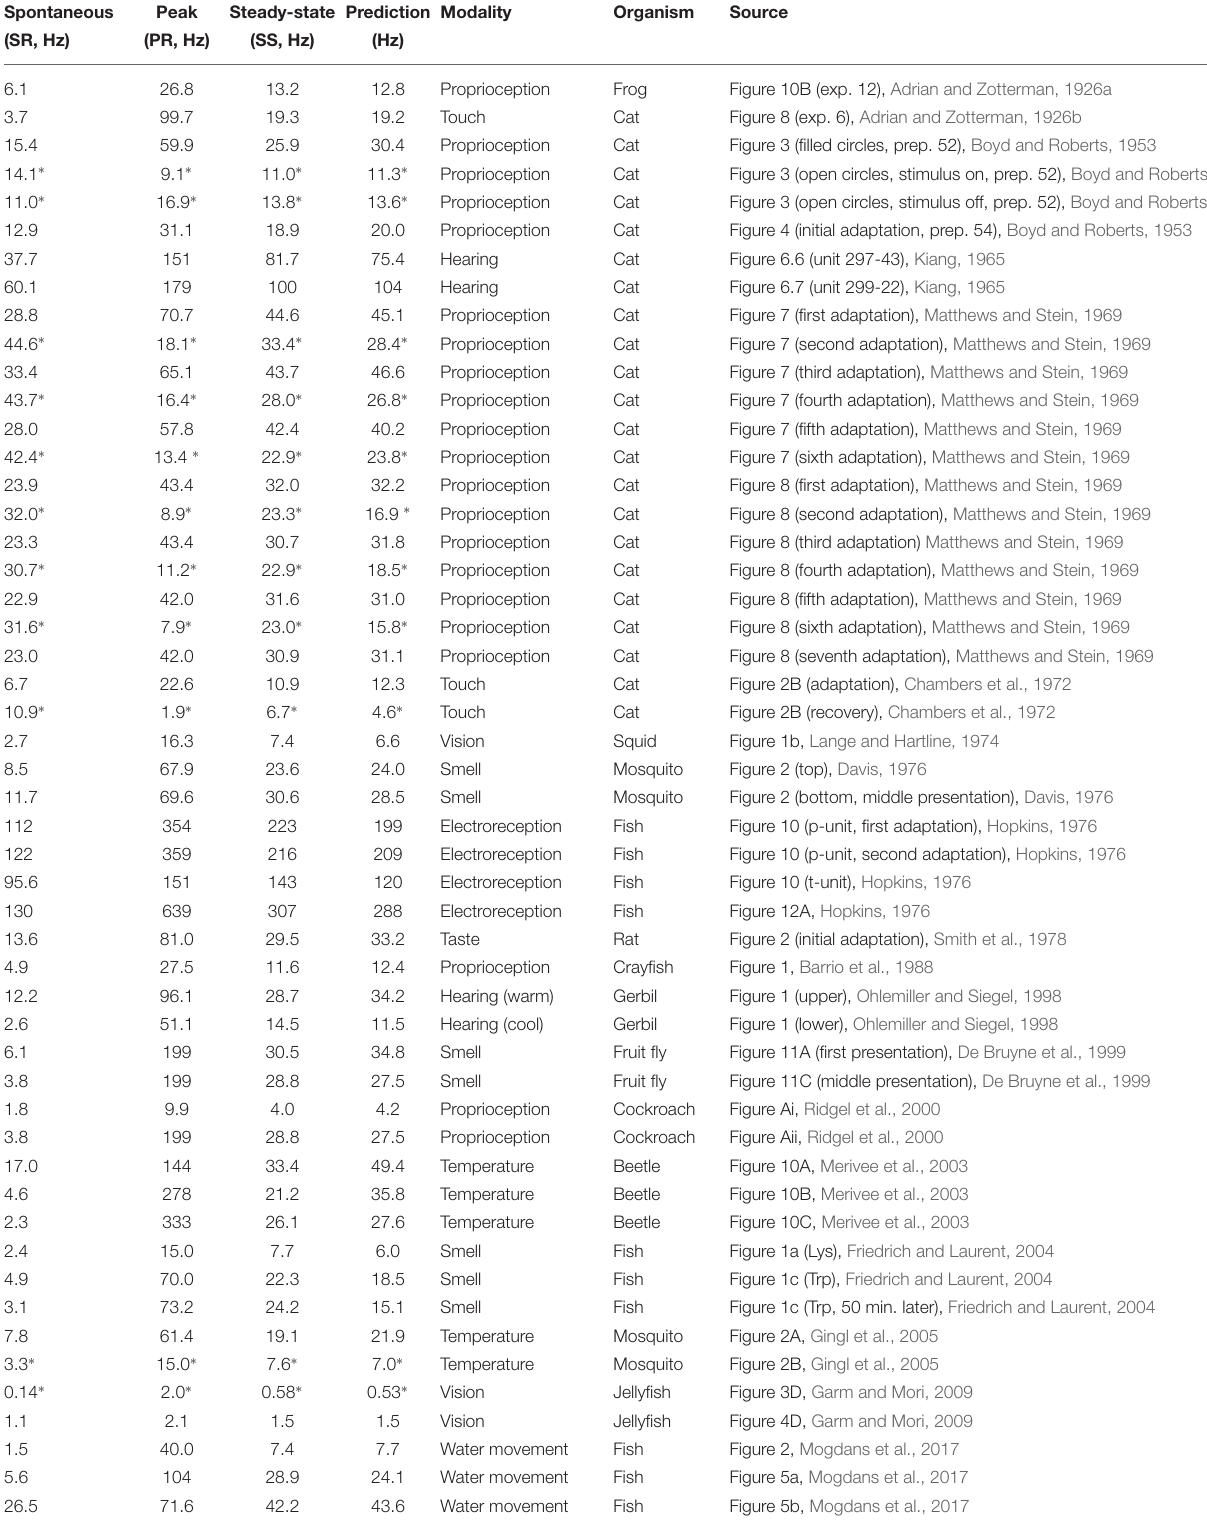
TABLE 1 | A summary of different peripheral sensory adaptation results highlighting the relationship between spontaneous, peak, and steady-state activities for different modalities and organisms. Spontaneous